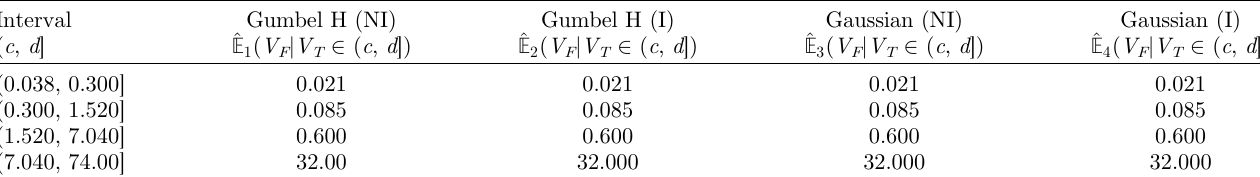
Table 10. Original scale. E i , i = 1, 2 computed using Gumbel – Hougaard copula, E i , i = 3, 4 computed using Gaussian copula, i = 1, 3 from Non Informative settings, i = 2, 4 from Informative